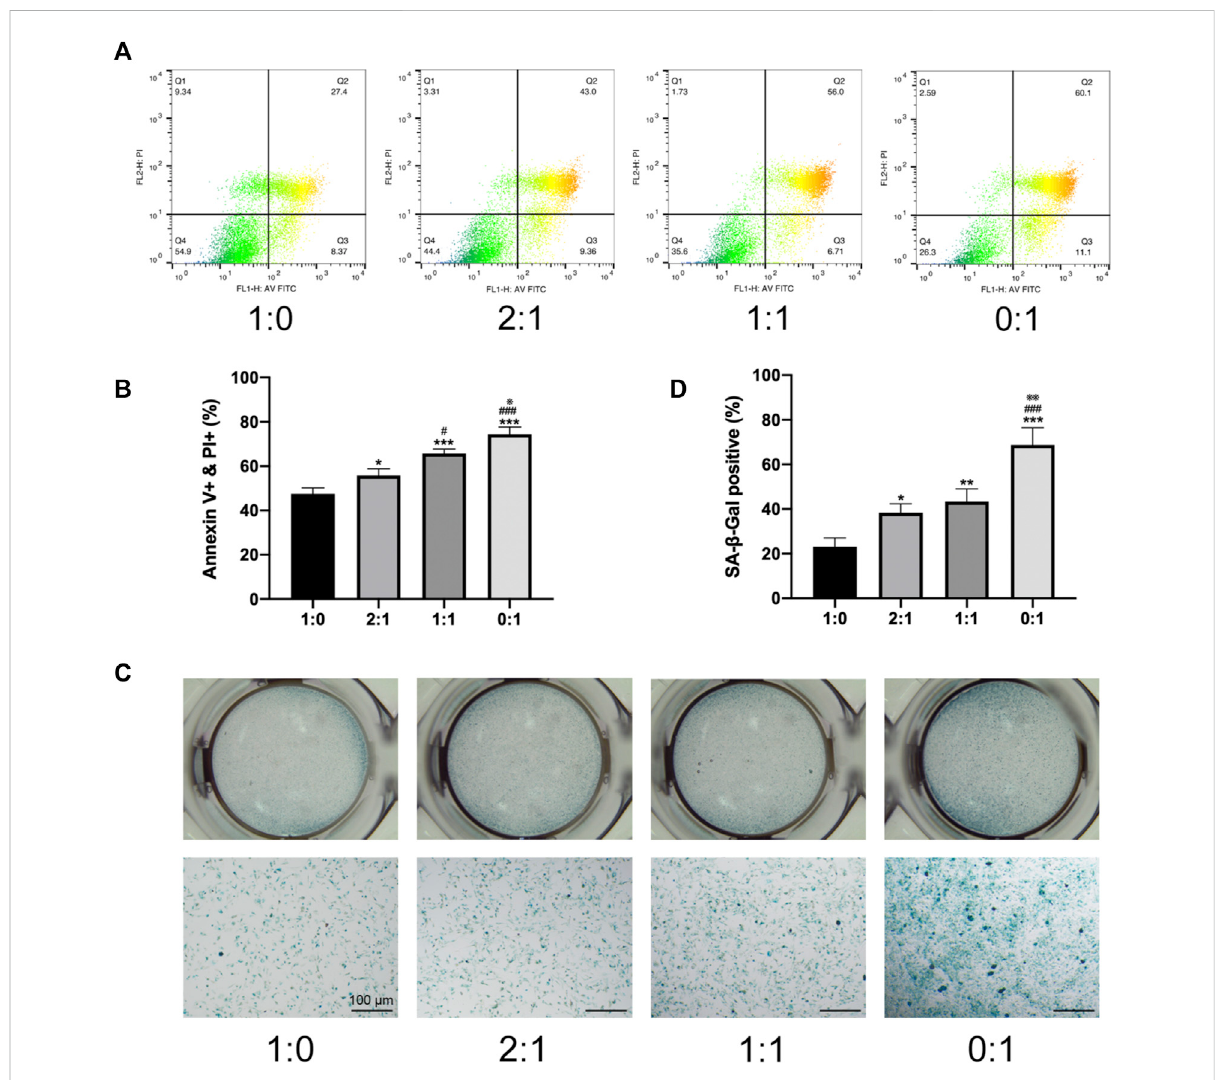
FIGURE 2 In vitro survival of MSCs within microtissue constructs. (A) . Apoptosis of MSCs in different groups of microtissue constructs measured by fl ow cytometry. (B) . Quantitative analysis of the proportion of Annexin V positive and PI positive cells. (C) . SA- β -Gal staining images of for cells lysed